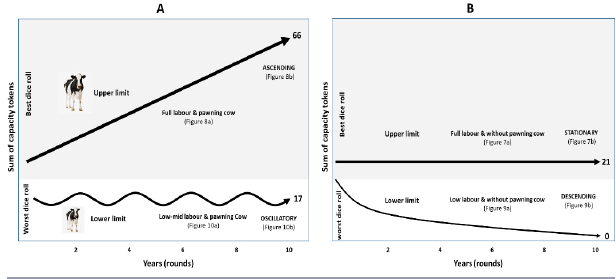
Fig. 7. Exploration of solution space in The Flow of Peasant Lives by the research team (internal validation of the game). (A) Upper limit (ascendant trajectory) and lower limit (oscillatory trajectory) of generating capacities while pawning the cow and using different levels of labor under favorable and unfavorable conditions of the dice (social fields). (B) Upper limit (stationary trajectory) and lower limit (descendent trajectory) of generating capacities without pawning the cow and using different levels of labor under favorable and unfavorable conditions of the dice.